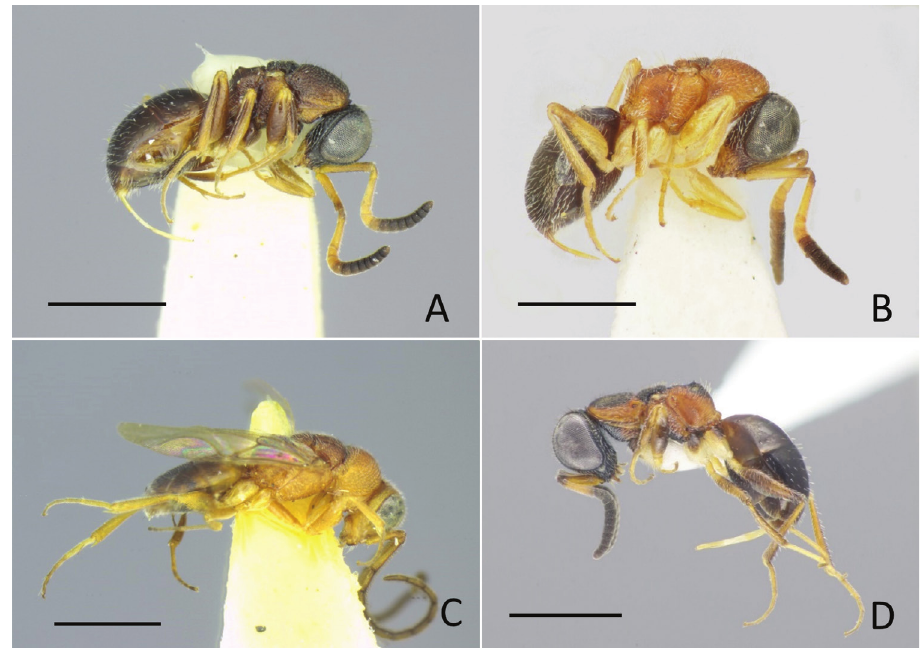
Figure 1. General habitus of Amiseginae A Baeosega humida Krombein, holotype ♀ B B. torrida Krombein, holotype ♀ C ditto, allotype ♂ D Nipponosega lineata sp. nov., holotype ♀ . Scale bars: 1.0